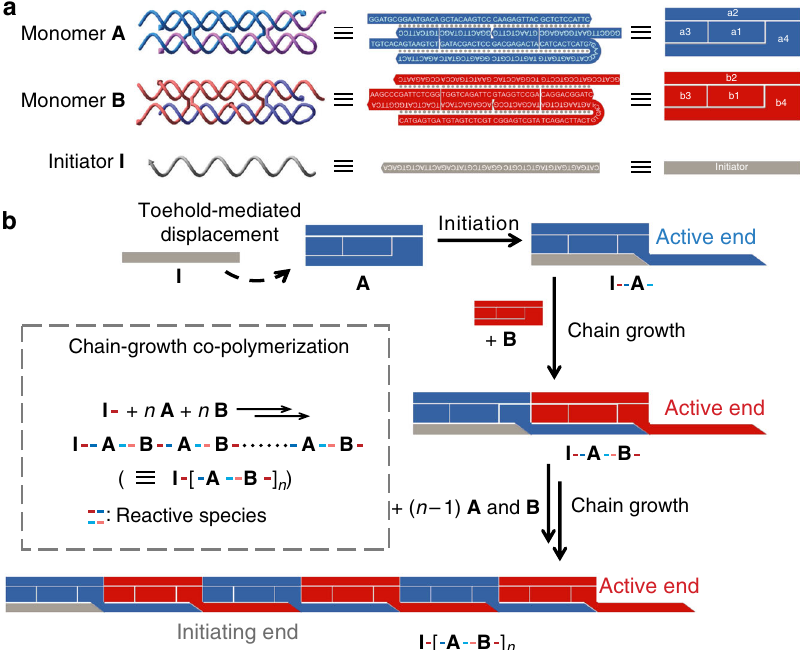
Fig. 1 Programmable chain-growth copolymerization of DHTs to form 1D nano fi laments. a Schematics of structures (left), sequences (middle), and simpli fi ed cartoons of two DHT monomers A (blue) and B (red) and initiator strand I (gray). Each monomer is assembled from four single-stranded DNA. Strand a1 or b1 serves as a rigid core linking two crossover junctions. Strands a2 to a4 and b2 to b4 provide sticky ends for associations with the complementary sequences in the neighboring monomers of the copolymer. Strand a4 or b4 also serves as hairpin domain with a toehold to be activated in strand displacement reactions (SDRs) for chain-growth copolymerization. b Chain-growth supramolecular copolymerization of monomers A and B initiated with I . The copolymerization starts with the SDR of initiator I with monomer A . The exposed loop sequence of activated A invades the hairpin domain of B to activate it with an exposed sequence identical to I , which could further activate another monomer A . The completed chain-growth copolymerization is achieved by alternating activation and propagation of monomers A and B . (Inset) Simpli fi ed diagram of chain-growth